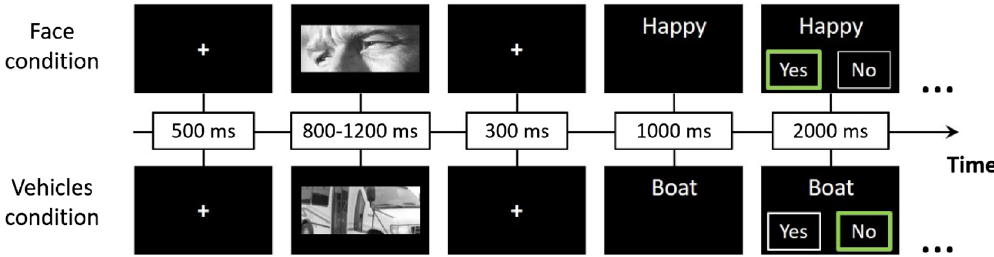
Figure 1. Behavioral paradigm—an example of two separate trials. The experimental procedure was adapted from the ’Reading the Mind in the Eyes’ Task (RMET). It consisted of eight blocks—half contained pictures of faces (social condition, see example above the line) and the other half contained pictures of vehicles (non-social condition, see example below the line). The task lasted approximately 13 min in total. The order of the blocks and the order of the pictures inside each block were randomized and counterbalanced across participants. The three dots at the end of each row mark the continuity of the